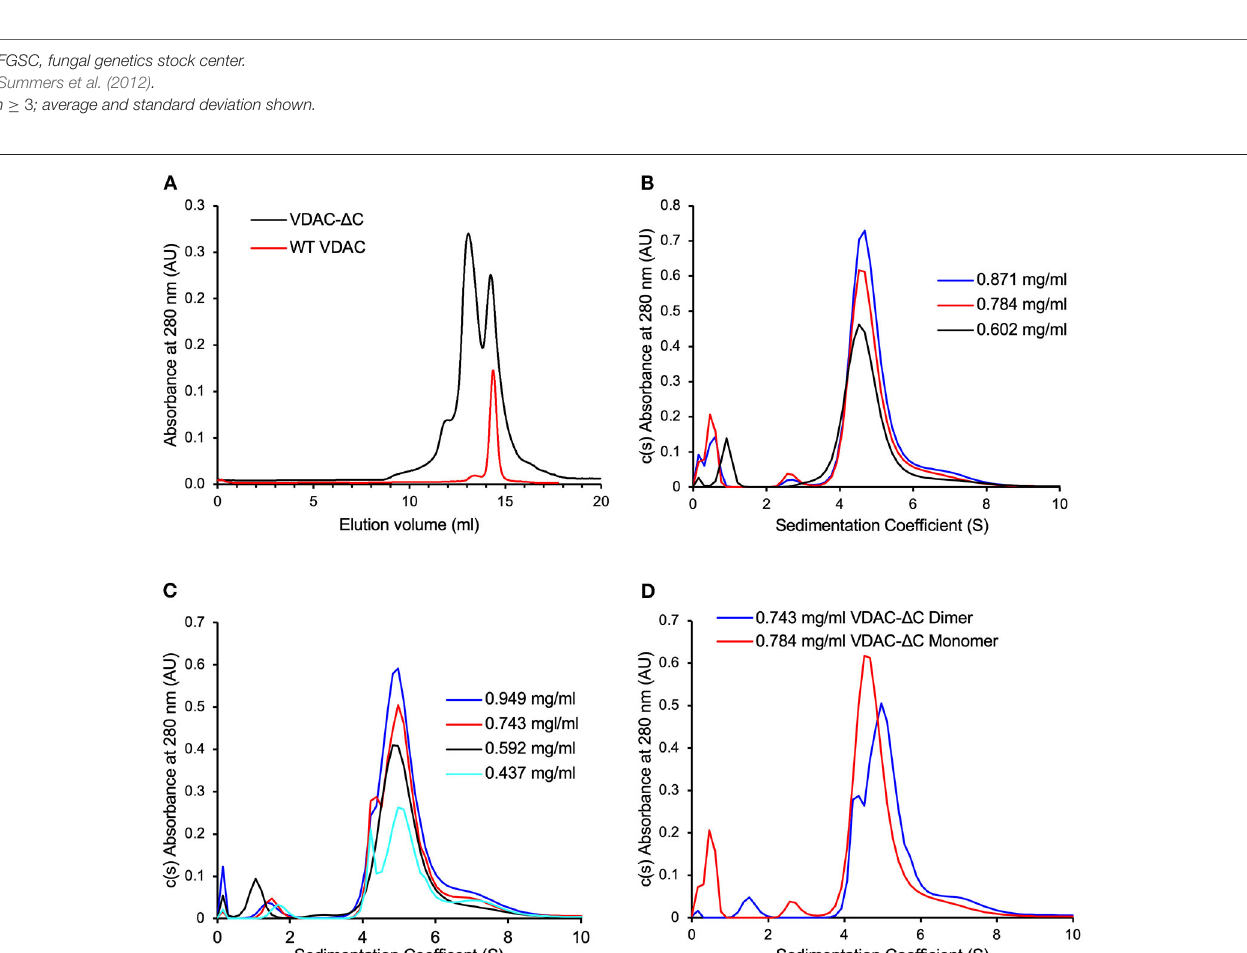
Frontiers in Physiology |